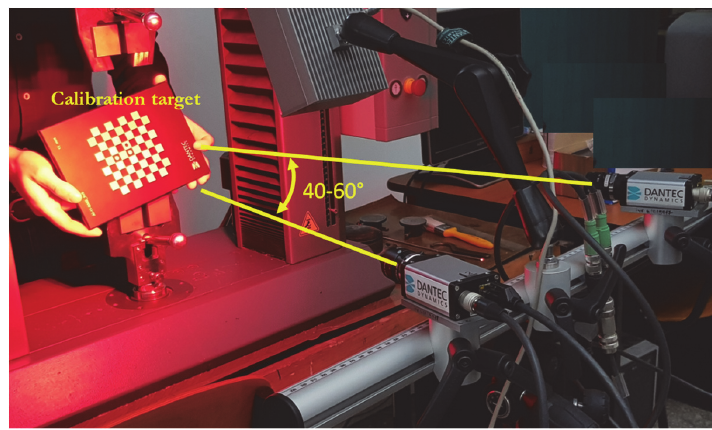
Figure 9: Correlation system with calibration target.